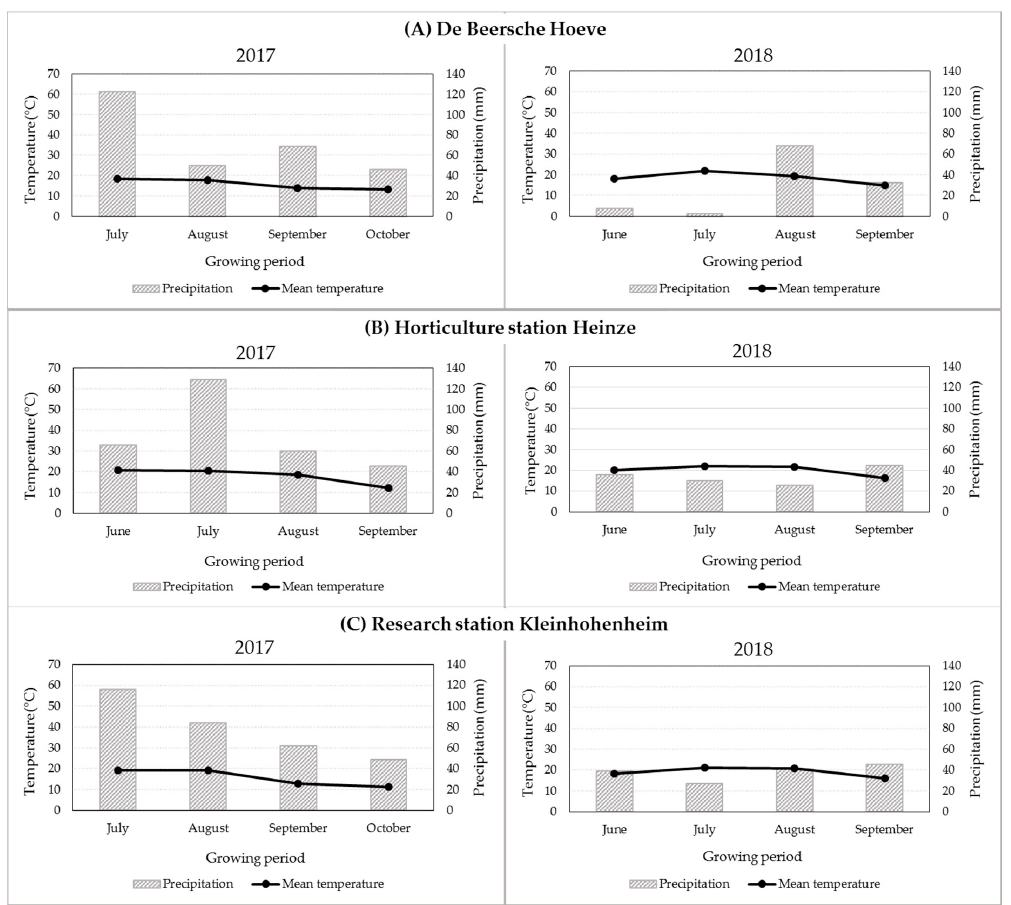
Figure 1. Total monthly precipitation (mm) and monthly mean temperature (°C) of the on-farm breeding station De Beersche Hoeve (the Netherlands) ( A ), the Horticulture station Heinze (Germany ( B ), and research station Kleinhohenheim (Germany) ( C ) during the experimental period in 2017 and 2018.